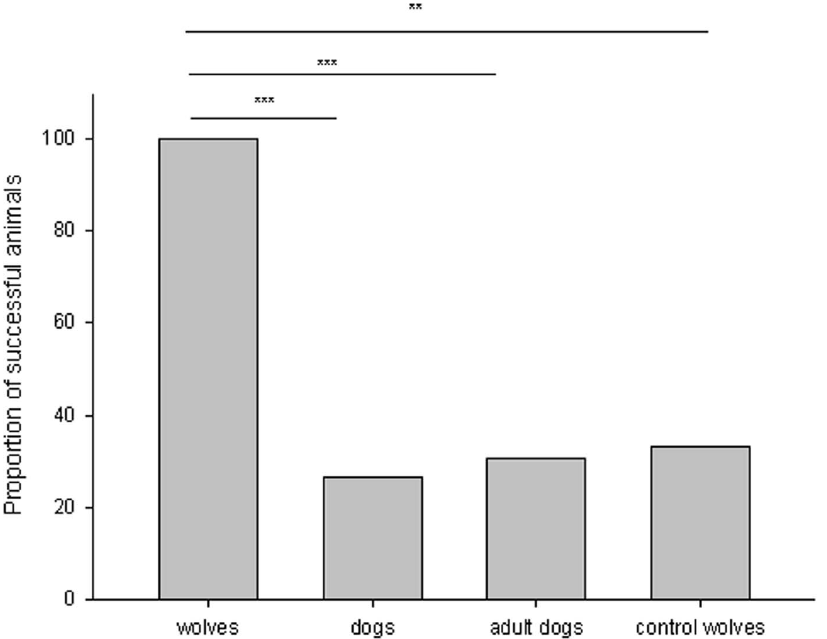
Figure 2. The graph depicts the proportion of animals that successfully opened the box in their first trials in the 4 test groups (wolf and dog test groups, adult dog control group, wolf control